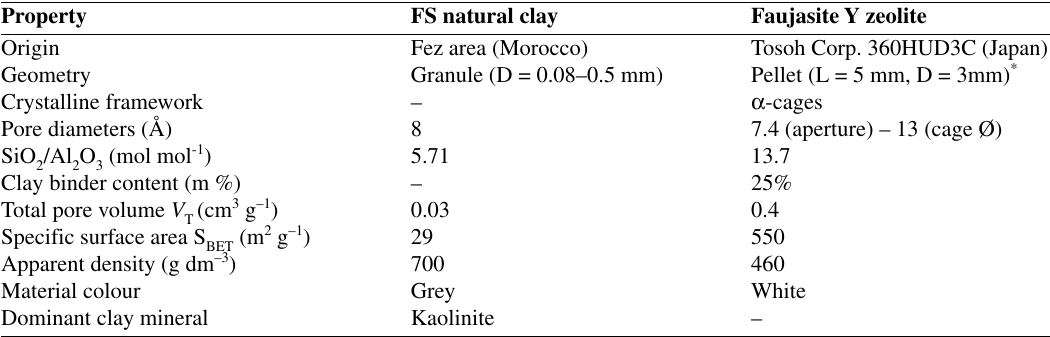
Table 1 . Physical–chemical properties of FS natural clay and Fau Y zeolite Property